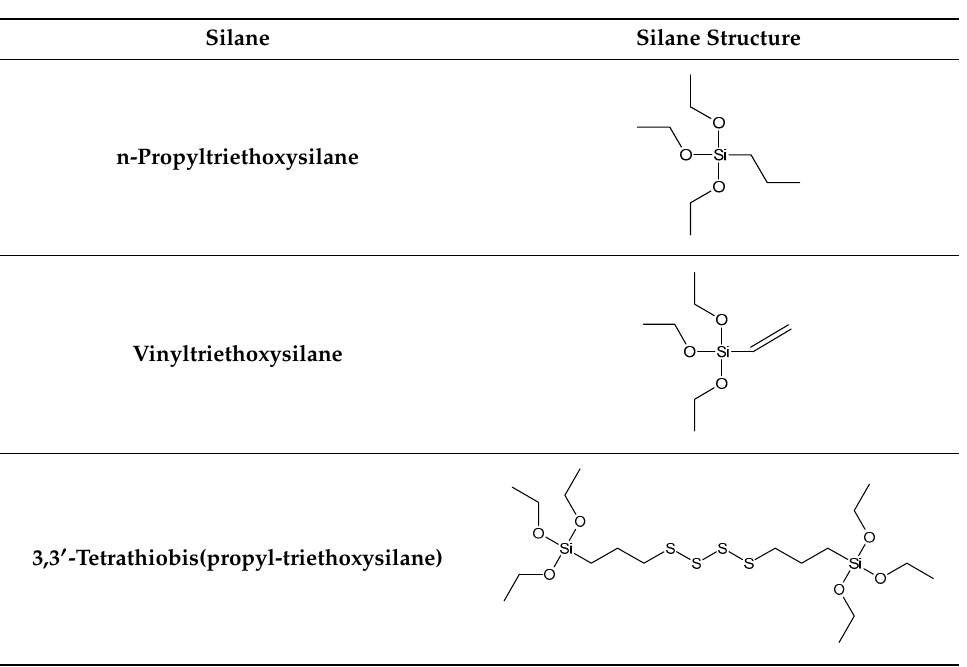
Table 1. Silane structures.